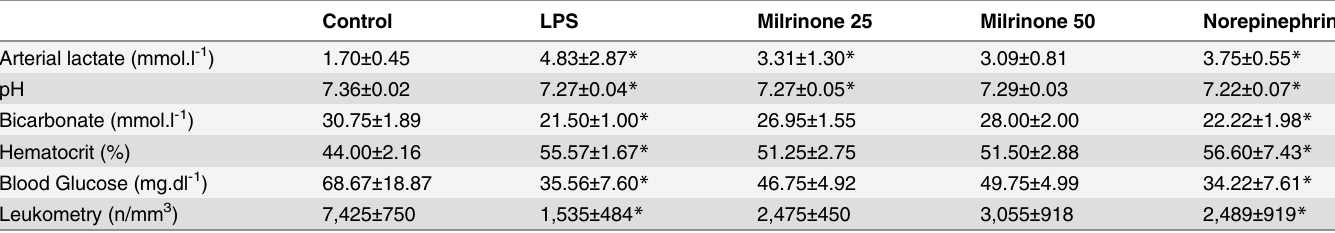
Table 2. Biochemical and hematological parameters.